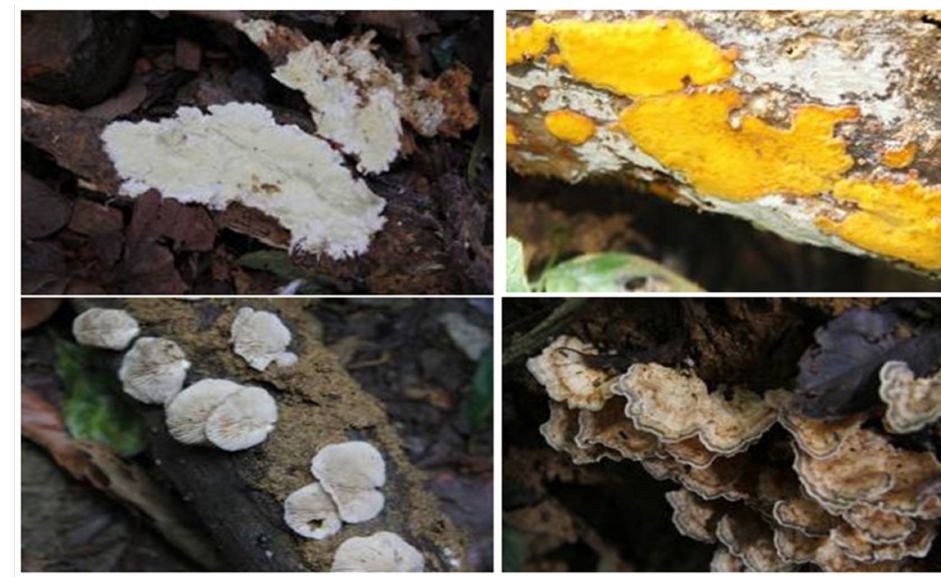
Figure 1. Some pictures at the humus sample collection points in Cuc Phuong tropical